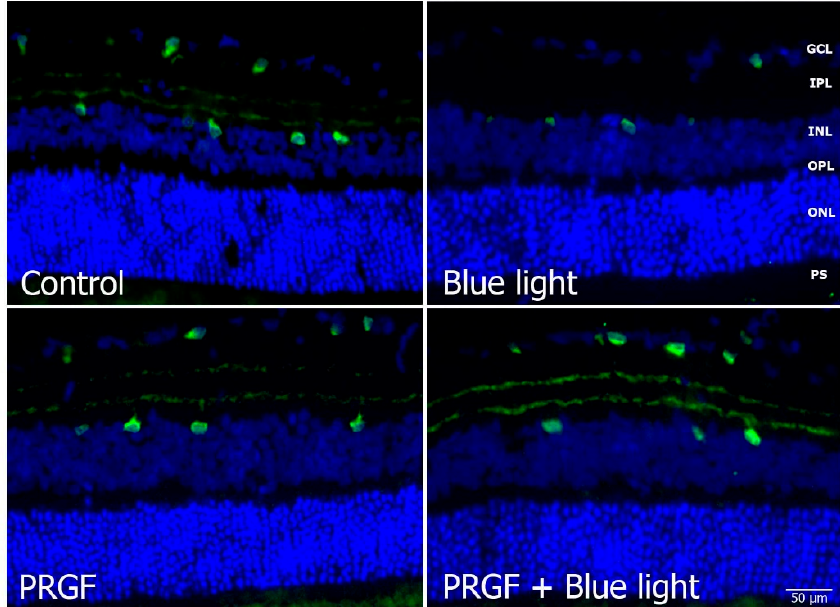
Figure 5. Immunofluorescence for ChAT (green) and DAPI (blue) in transversal section of retinas ( n = 4). The results showed that blue light decreased its expression compared to the control. However, PRGF combined with blue light recovered the expression. Scale = 50 µm.